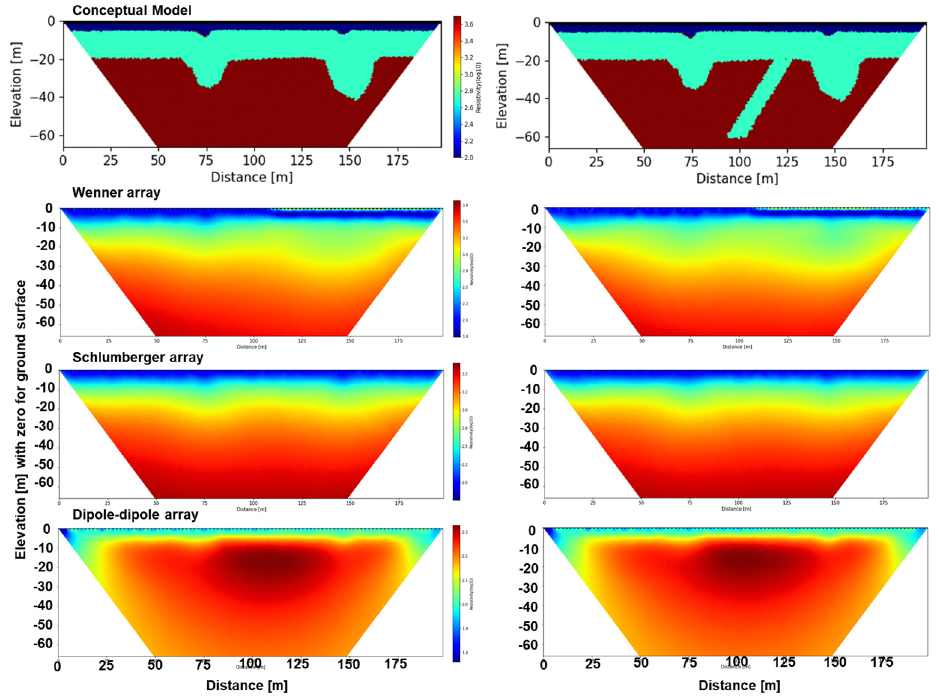
Figure 7. Results of forward simulation with a three-layer conceptual model with a 2 m wide subvertical fracture ( right ) and without fracture ( left ) in the top row. Inversion results from synthetic data obtained from a forward simulation using this model representation are shown in rows 2, 3, and 4 for Wenner, Schlumberger, and dipole–dipole electrode arrays, respectively.